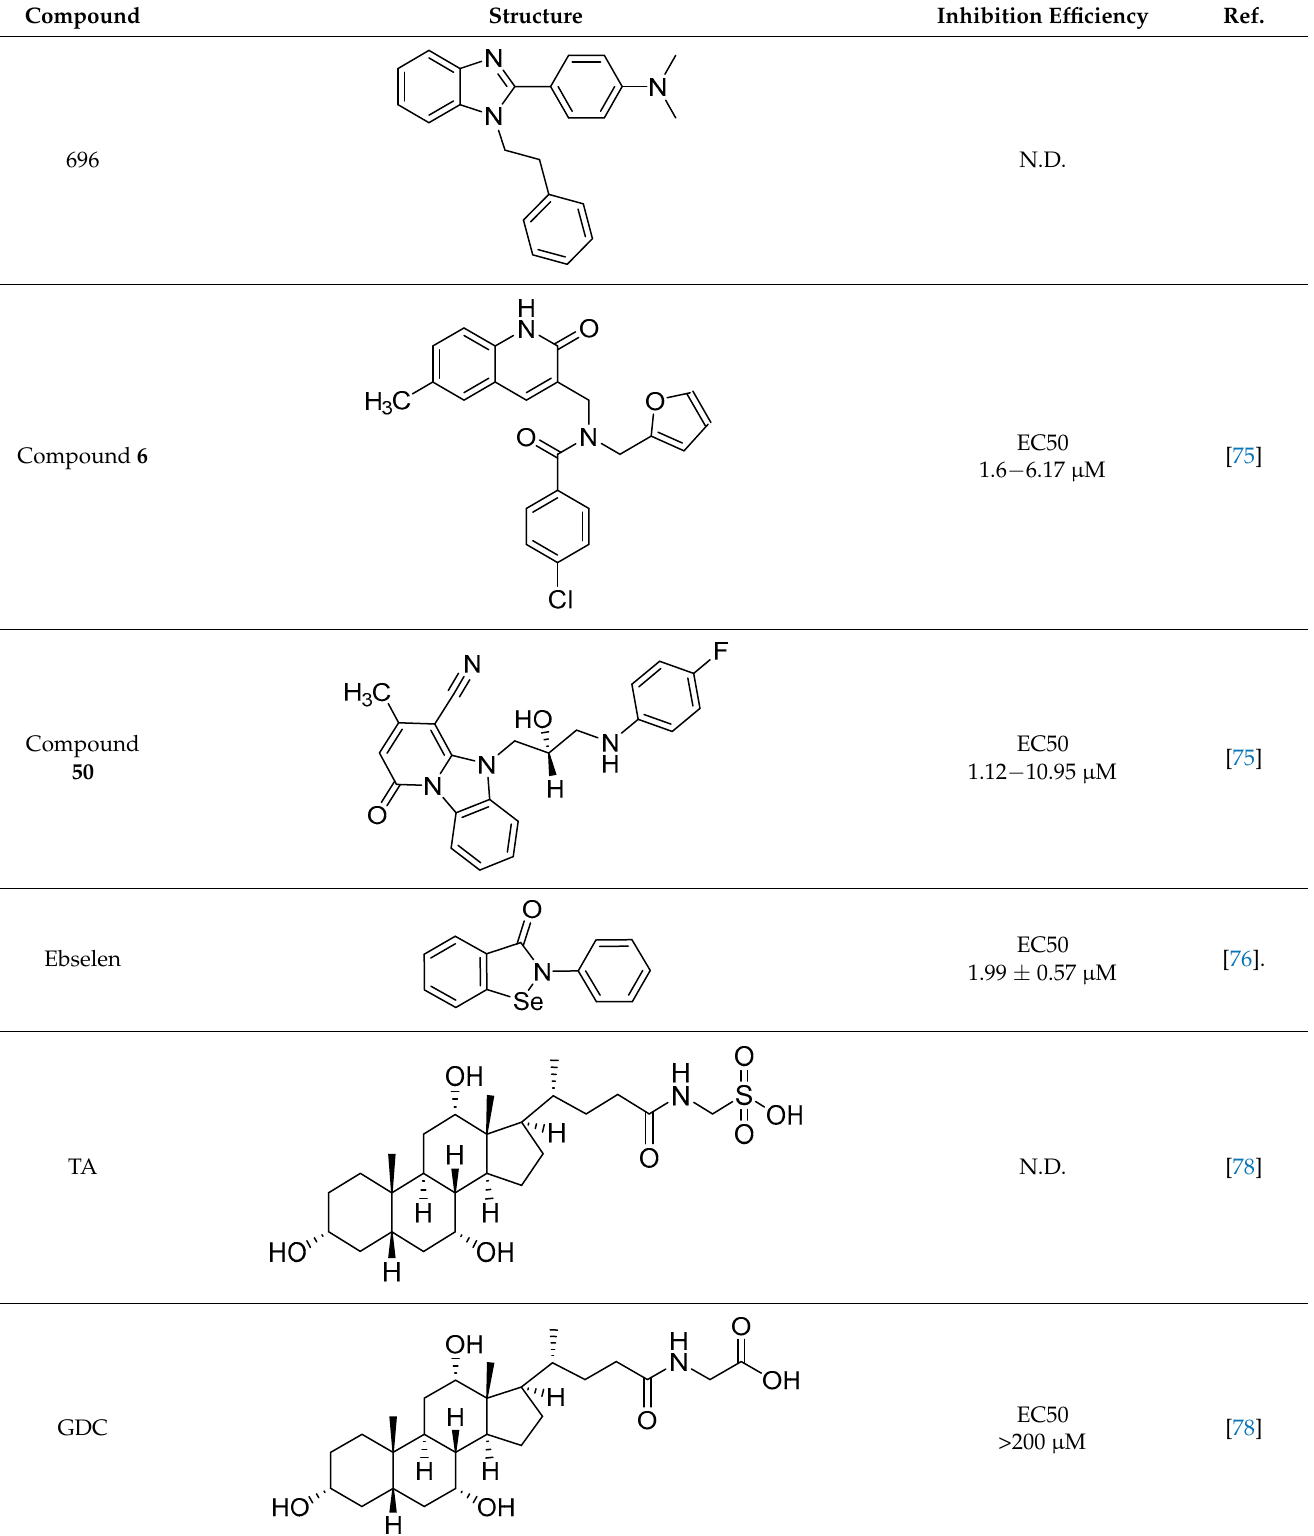
Table 1. Cont. Compound Structure Inhibition Efficiency